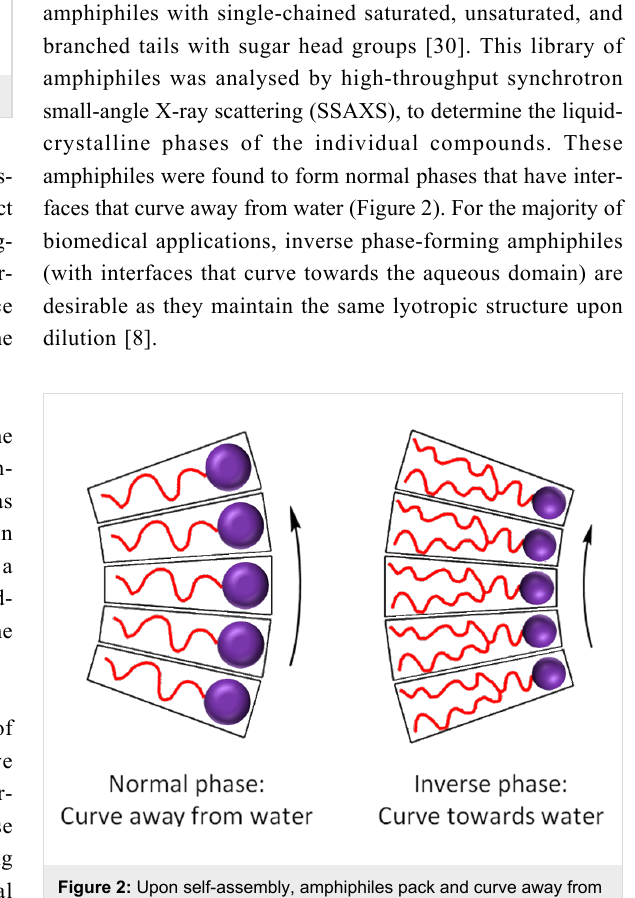
Figure 2: Upon self-assembly, amphiphiles pack and curve away from (normal phase) or towards (inverse phase)